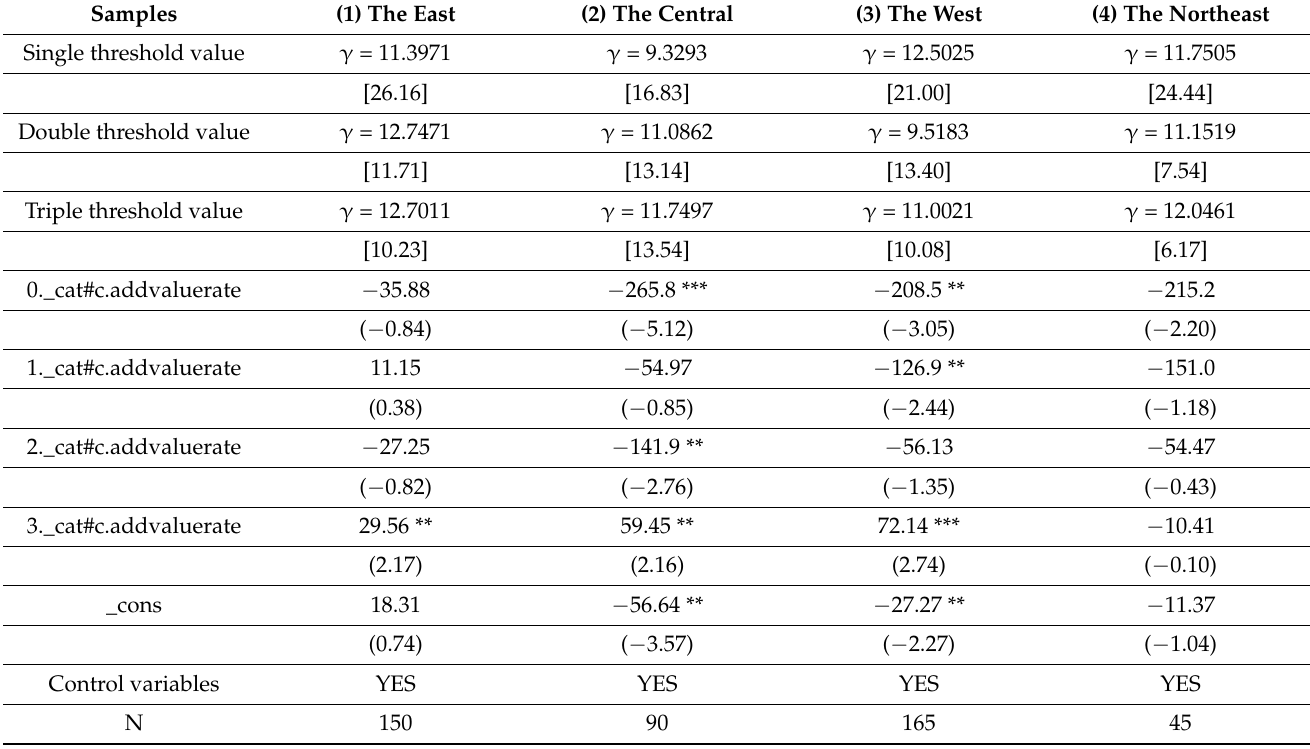
Table 6. Regression results of threshold effects in different